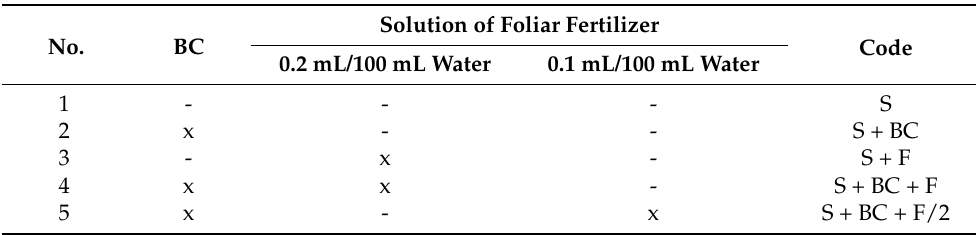
Table 1. Treatments used in the greenhouse experiment. No.